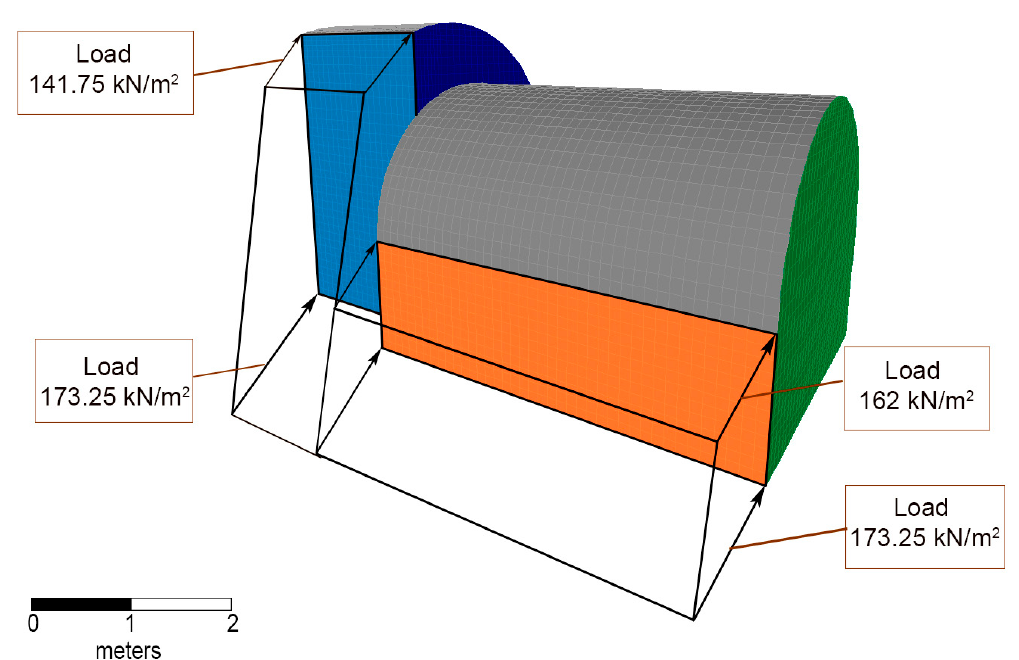
Figure 4. Values of soil thrust on two walls of the wine cellar.